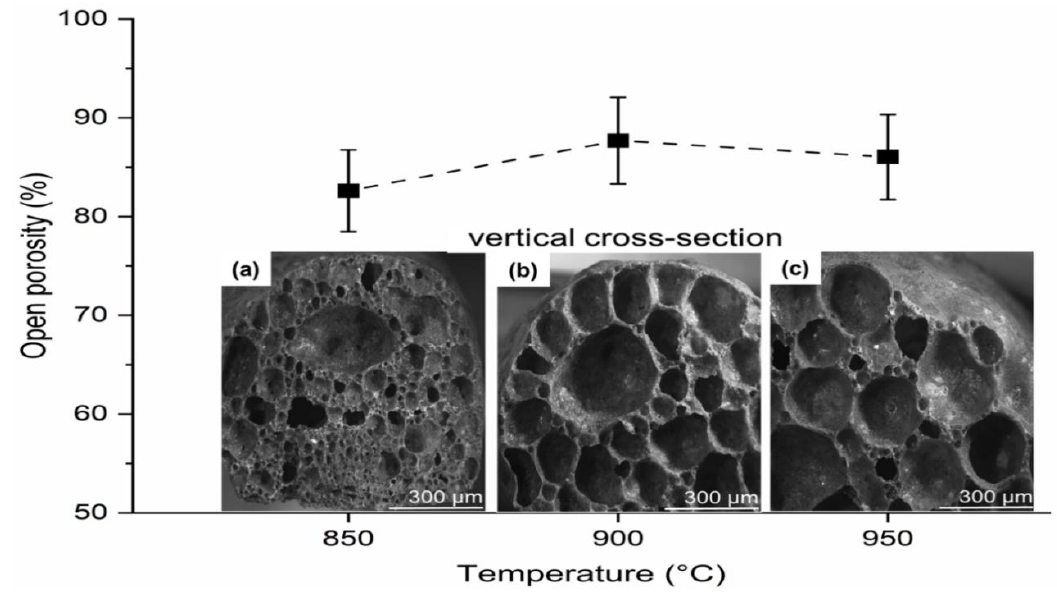
Figure 7. Porosity and geometric formation of pores of glass foams sintered at ( a ) 850 °C, ( b ) 900 °C, and ( c ) 950 °C.